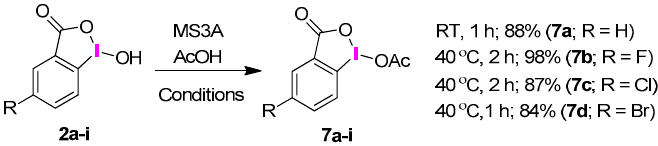
cessfully afforded R-IB-OAc 7b – d containing fluoro-, chloro-, and bromo-substituents;